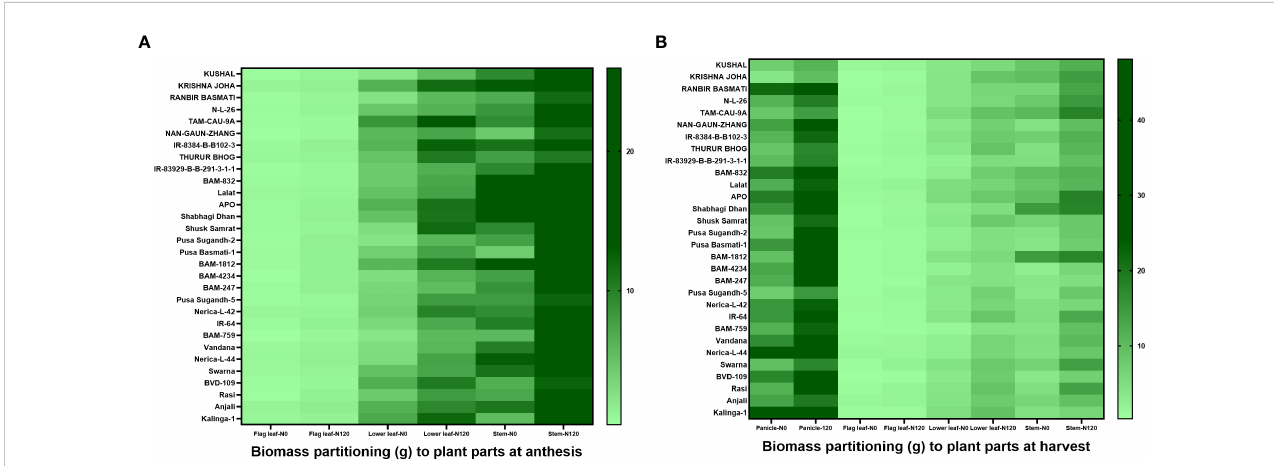
FIGURE 1 Effect of nitrogen de fi cient (0 kg ha-1 fertilizer N: N0) and nitrogen suf fi cient (120 kg ha-1 fertilizer N: N120) fi eld conditions on biomass partitioning to plant parts at (A) anthesis ( fl ag leaf, lower leaf, and stem) stage and (B) harvest (panicle, fl ag leaf, lower leaf, and stem) stage in fi eld- grown diverse rice genotypes during the 2019-kharif season. Values presented are Mean±SE with three